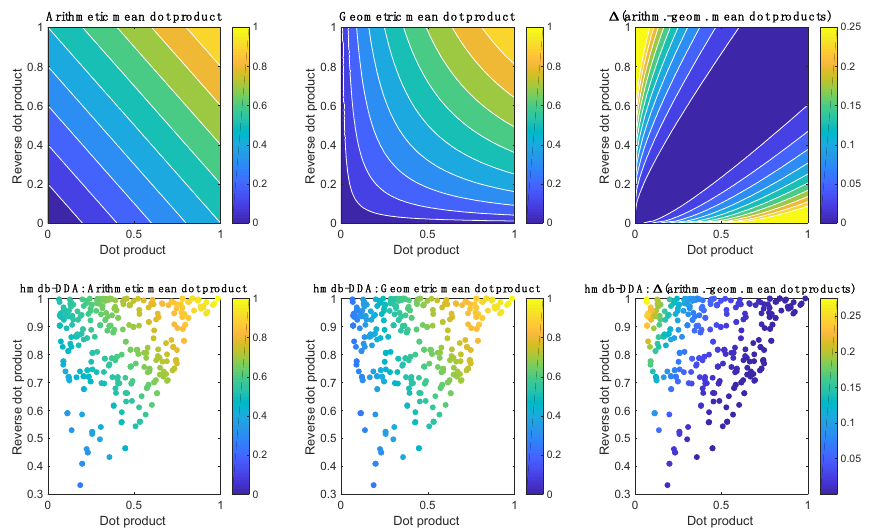
Figure 7. (Top) Surface plots of the arithmetic (left) and geometric (middle) means and the difference between the arithmetic and geometric means (right) of dot and reverse dot products in the 0–1 range. Bottom) Distribution of experimental dp and rdp values obtained in this study for LC–MS features annotated based on MS 2 data acquired using hmdb-DDA. The color indicates the arithmetic (left) and geometric (middle) means, as well as the difference between the arithmetic and geometric means (right).